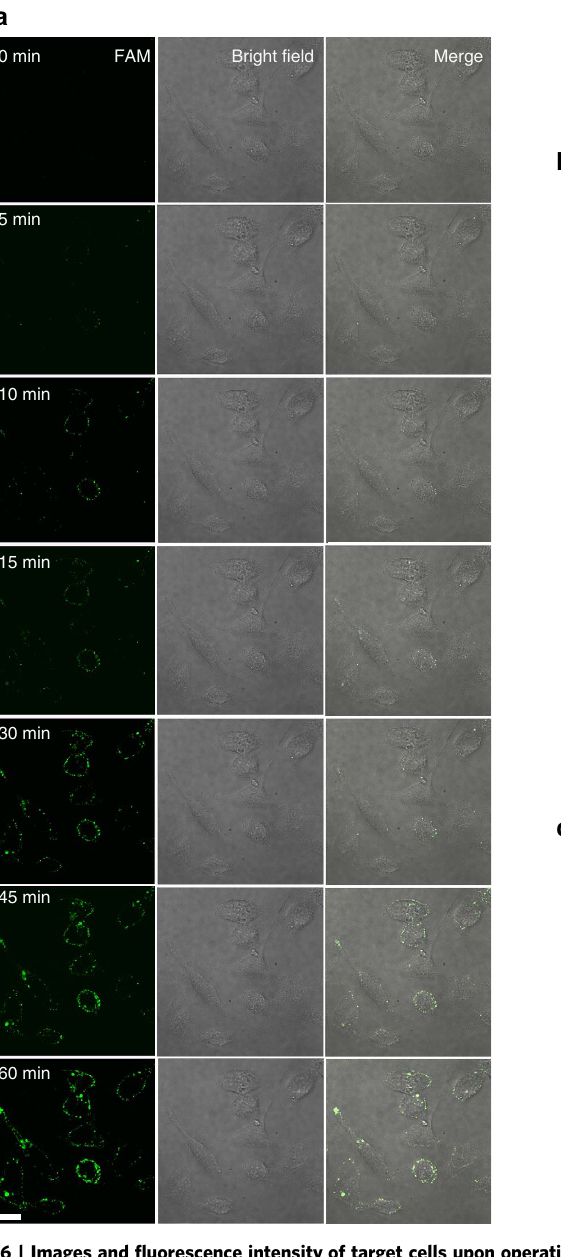
Figure 6 | Images and fluorescence intensity of target cells upon operation of the DNAzyme motor. The DNAzyme motor was designed to respond to the intracellular miRNA miR-10b. ( a ) Images of MDA-MB-231 cancer cells after intracellular operation of the DNAzyme motor for 0, 5, 10, 15, 30, 45 and 60min. 0min refers to the time point when Mn 2 þ is added into the operating buffer. The LMM5 laser transmission setting was 85 and the laser excitation time was 185ms for each image. ( b , c ) Fluorescence intensity of six cells over the 60min operation time of the DNAzyme motor. The fluorescence intensity was measured using ImageJ 1.47. The length of the scale bar is 17 m